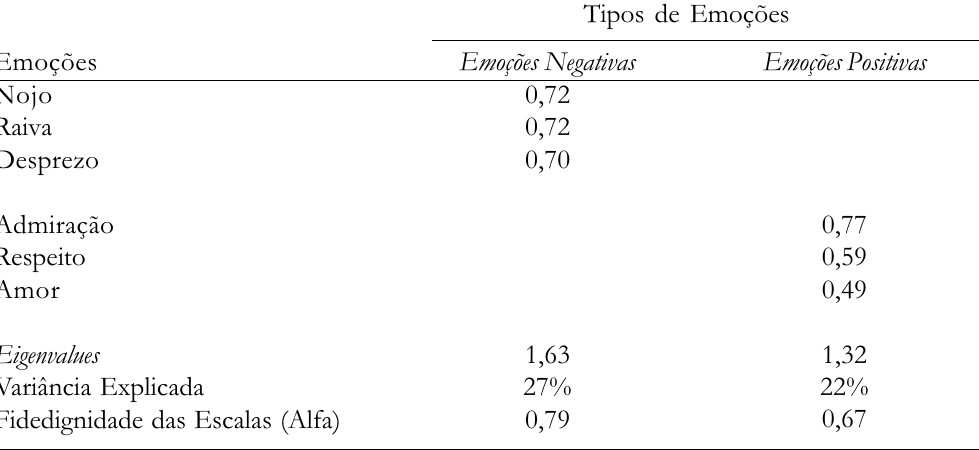
Tabela 2. Cargas Fatoriais, Eigenvalues, Vari(cid:226)ncia Explicada e Fidedignidade dos Tipos